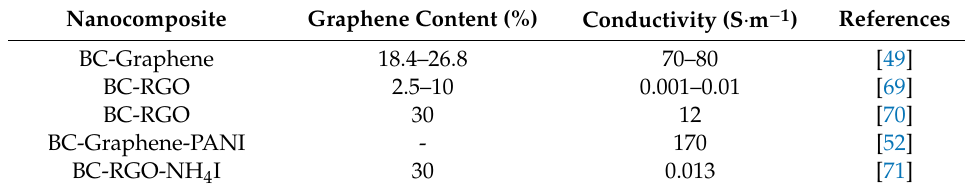
Table 2. Conductivity of BC-graphene nanocomposites reported by di ff erent studies.